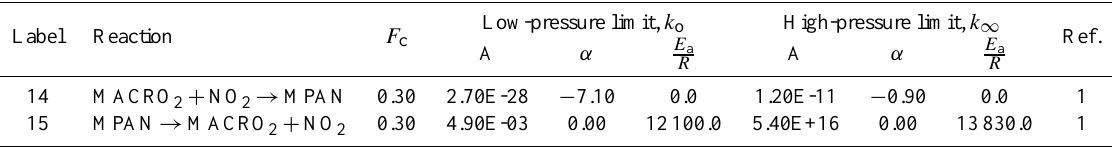
Table 10. Additional uni- and termolecular reactions associated with the Mainz Isoprene Mechanism in the UKCA TropIsop chemistry scheme, where MACR = lumped species consisting of methacrolein, methyl vinyl ketone and other C 4 carbonyls from isoprene chemistry, and MPAN = peroxy methacrylic nitric anhydride (and other higher PANs from isoprene chemistry). Rate coefficients for termolecular reactions are calculated using a modified Lindemann–Hinshelwood mechanism, i.e. k = the low- and high-pressure limits calculated in the same manner as bimolecular rate coefficients, and [ M ] is the number density in